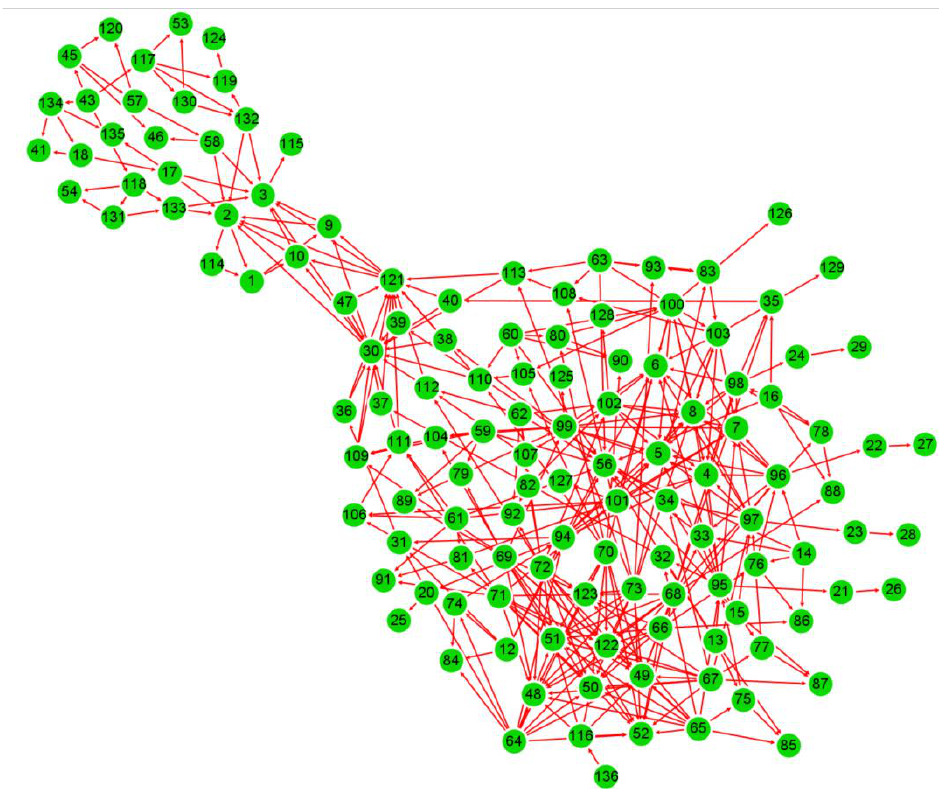
Figure 17. Causality network of the chlorobenzene production process.